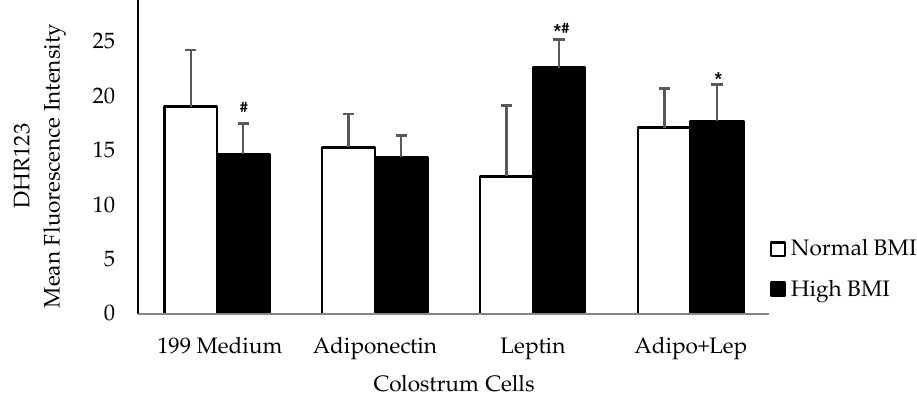
and samples ( p < 0.05).